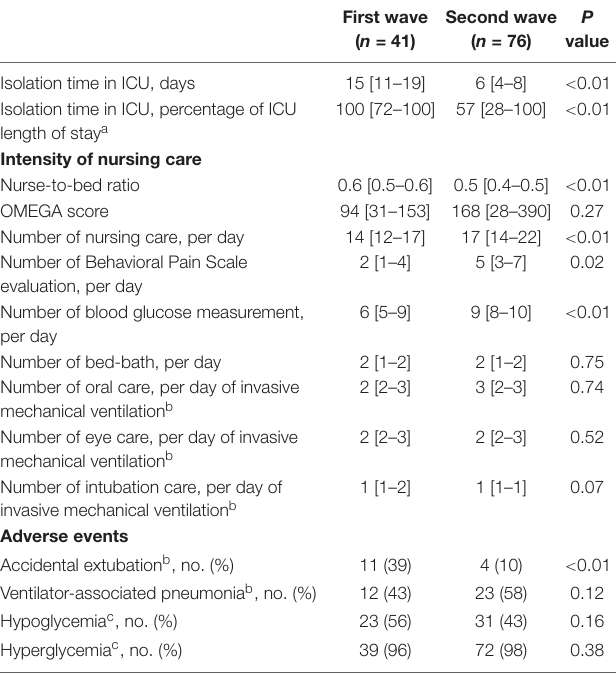
TABLE 2 | Patient management in the two pandemic